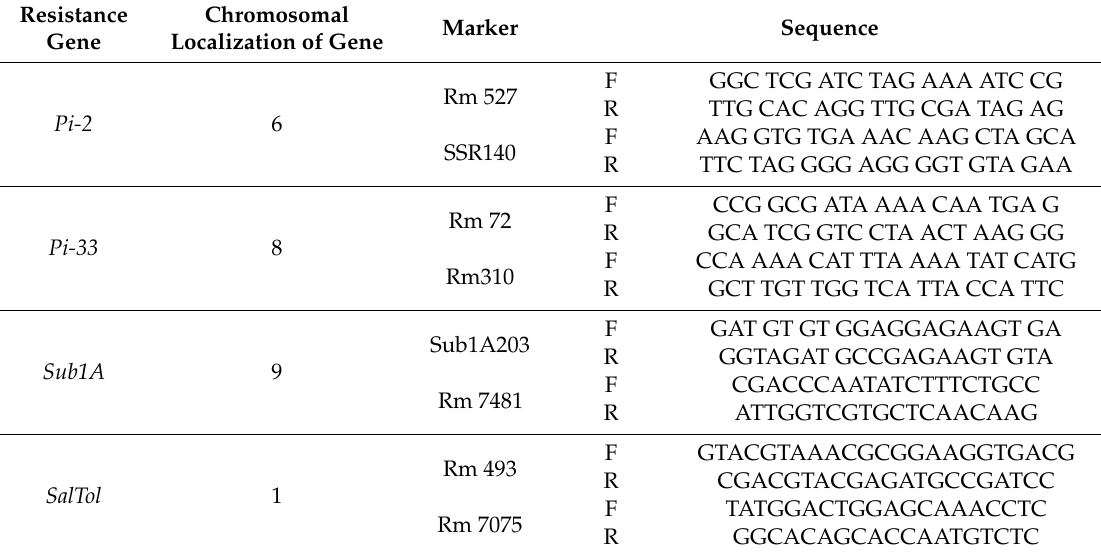
Table 1. Nucleotide sequences of codominant markers for identification of the allelic status of genes Pi-1, Pi-2, Pi-a, and